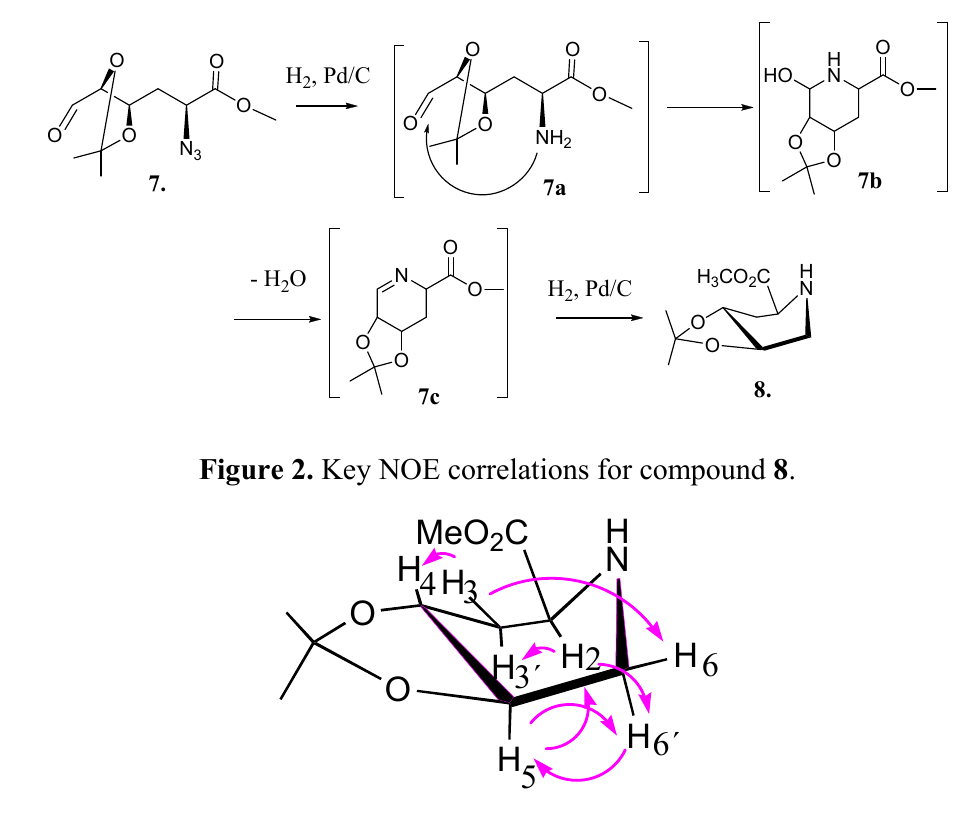
Figure 3. Minimum energy conformations of target compound 8 calculated by DFT (Gaussian 9.0)